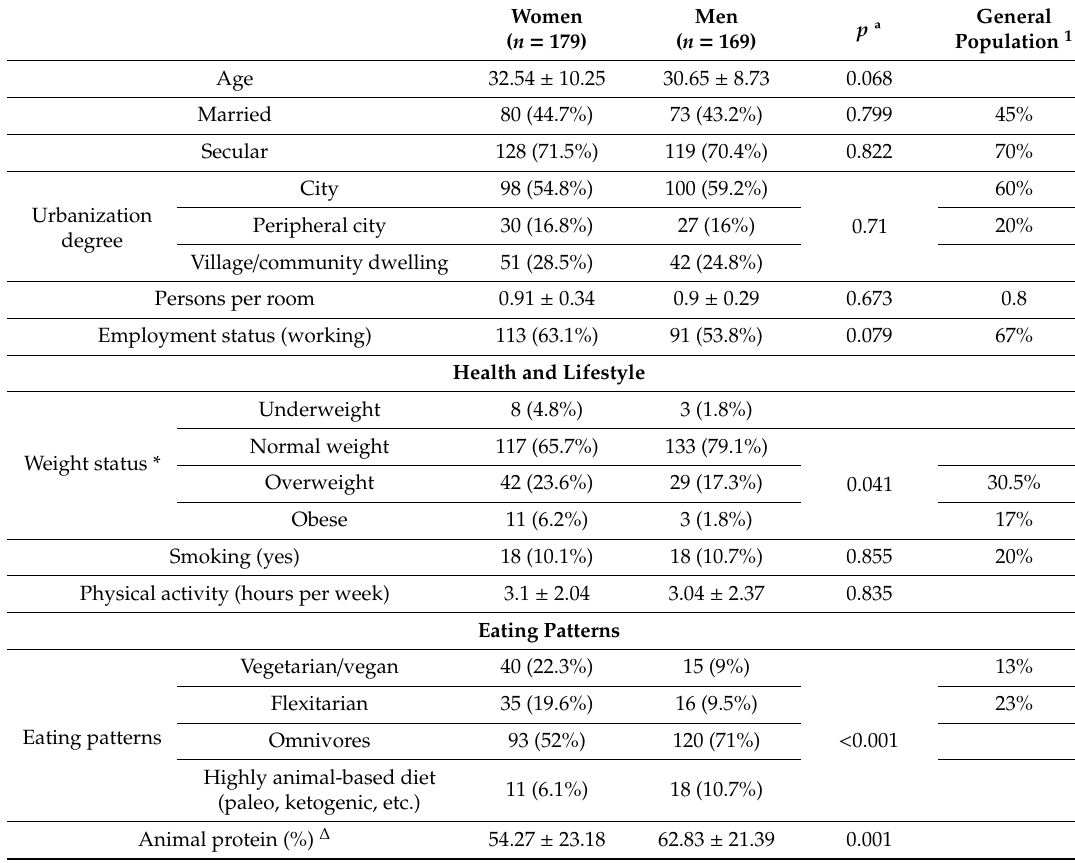
Table 1. Characteristics of the study population by